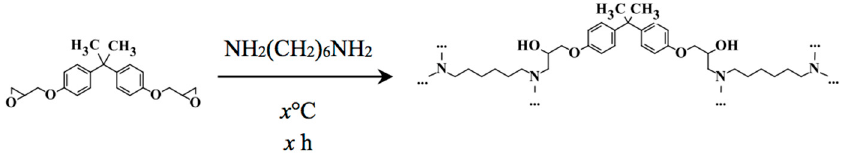
Figure 10. Reaction of Bisphenol A diglycidyl ether (BADGE) and 1,6-hexanediamine (HDA) with the formation of poly( β -alkanolamine) [22].